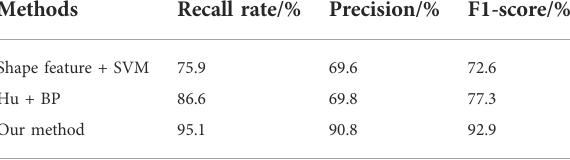
TABLE 5 Test results of different